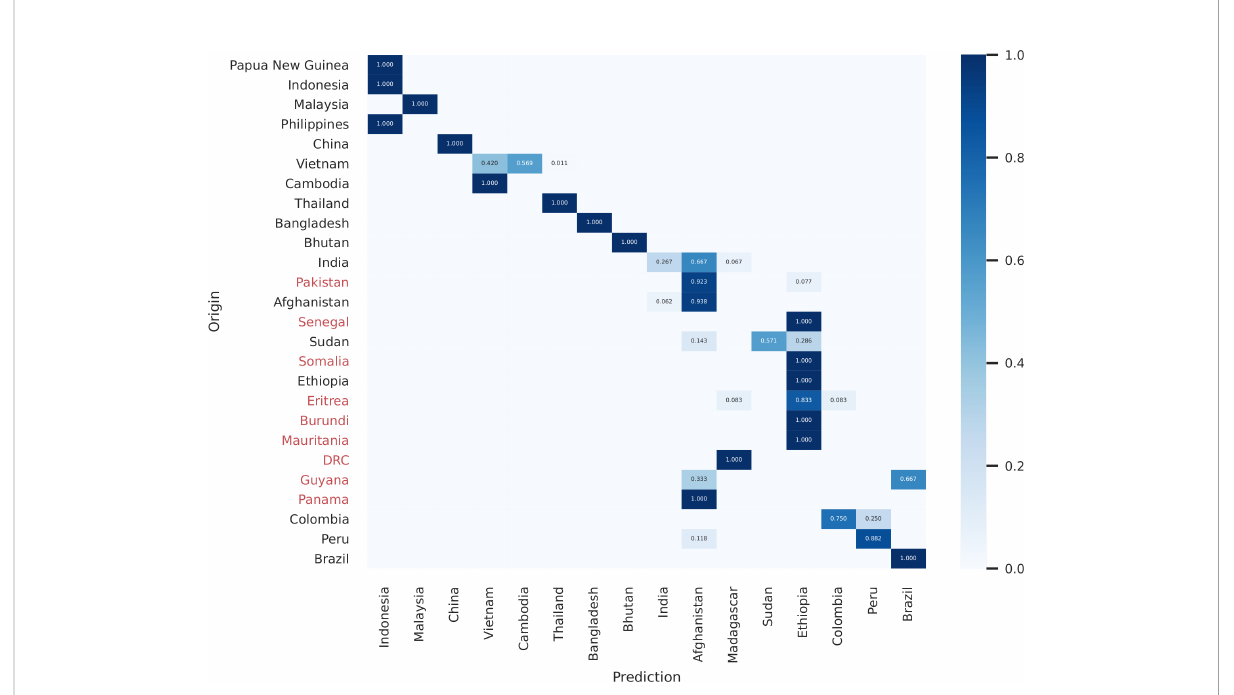
FIGURE 5 Heatmap of predicted origin in the likelihood model vs. expected origin of samples based on collection site and travel history using the 72-SNP barcode. Predicted origin of the samples was calculated with the vivaxGEN-geo likelihood classi fi er (Trimarsanto et al., 2019). Countries of origin that were not represented in the reference dataset and hence could not be directly predicted are indicated in red on the origin axis; these countries can be included in future iterations of the classi fi er to improve its accuracy. Only samples from patients who presented in malaria- endemic countries are illustrated (i.e., excluding samples from Spain, Singapore and Unknown origin samples that were present in the larger dataset). The strong diagonal trend illustrates the regional accuracy of the predictor, with most infections mapping directly to the country of origin or to neighboring countries e.g., with Vietnamese samples mapping to either Vietnam or Cambodia. In border regions with extensive parasite gene fl ow, many infections may not be classi fi able by national (political) boundaries, and regional boundaries may prove more useful administrative units for classi fi